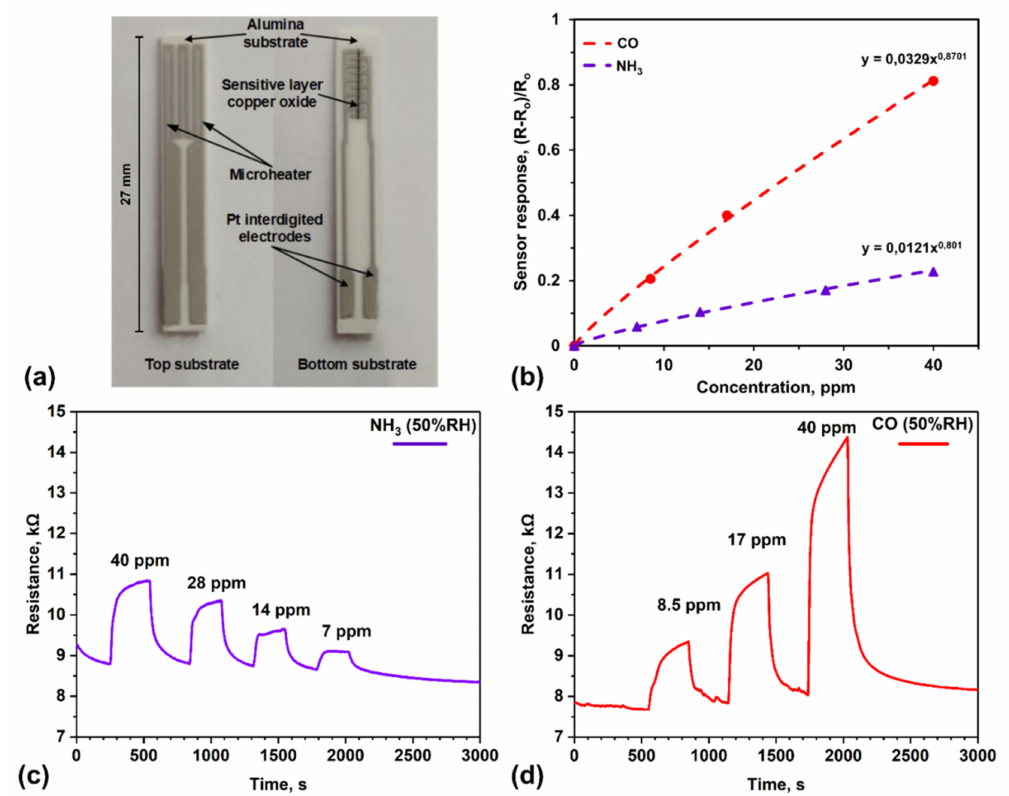
Figure 8. ( a ) Photo of a microstructure in the form of a printed line based on nanoparticles of copper oxide formed on alumina substrate for gas sensor testing. ( b ) Dependence of the relative changes in resistance and ( c , d ) the corresponding time responses of the gas sensitive layer on the concentration of NH 3 and